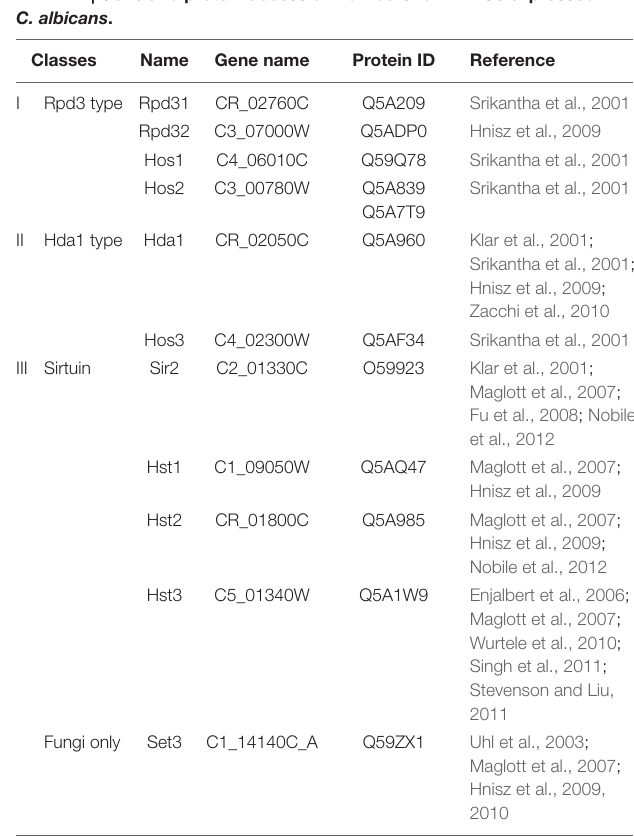
TABLE 1 | Gene and protein accession numbers for HDACs expressed in C. albicans